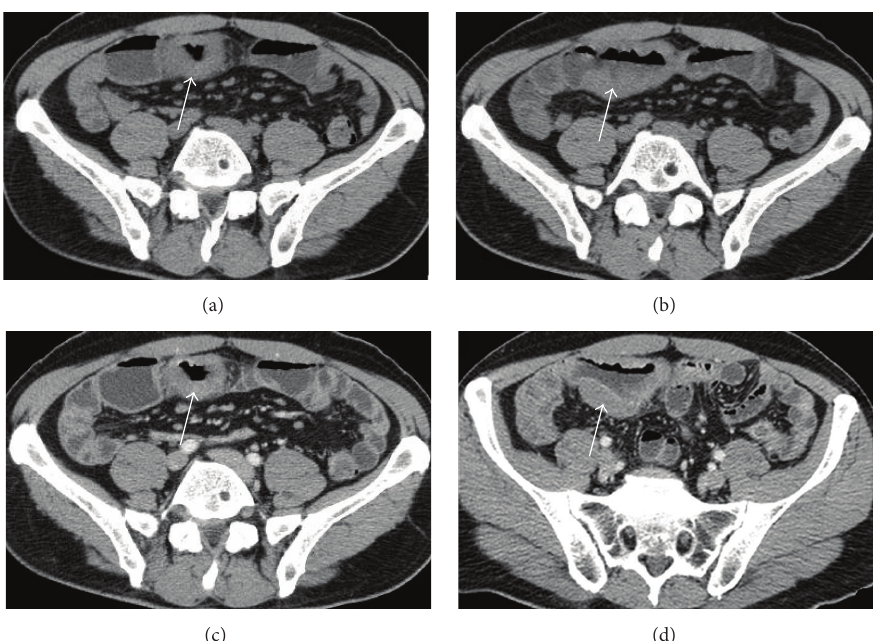
Figure 2: Abdominal CT scan in a 46-year-old male with celiac disease who developed an ileal lymphoma. Abdominal CT scan in the precontrastographic phase ((a) and (b)) and in the postcontrastographic phase ((c) and (d)) shows diffuse segmental (length: 8 cm) wall thickening (thickness: 1,5cm) (arrows) with mild contrast enhancement in an ileal loop. Multiple subcentimetric lymph nodes are detected near the affected loop in the mesenteric